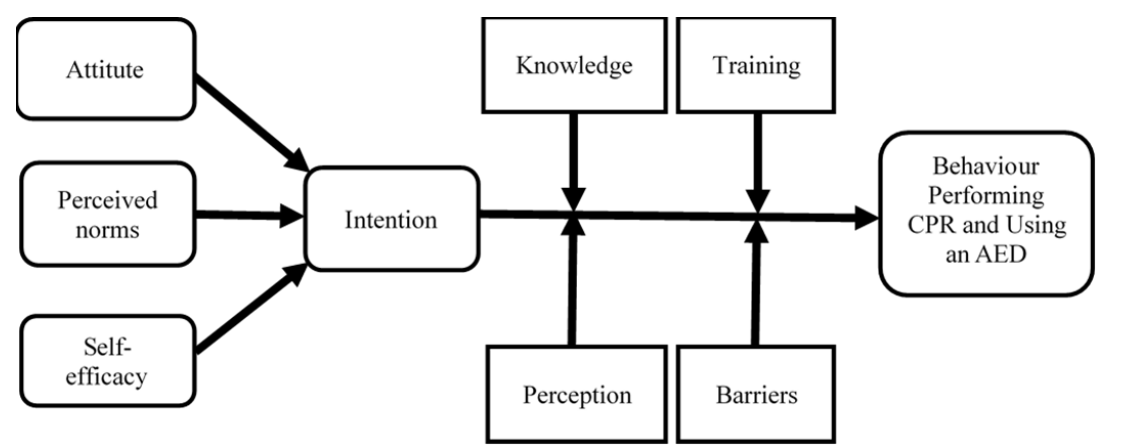
Figure 2. A conceptual framework of the community willingness to perform CPR and use an AED.